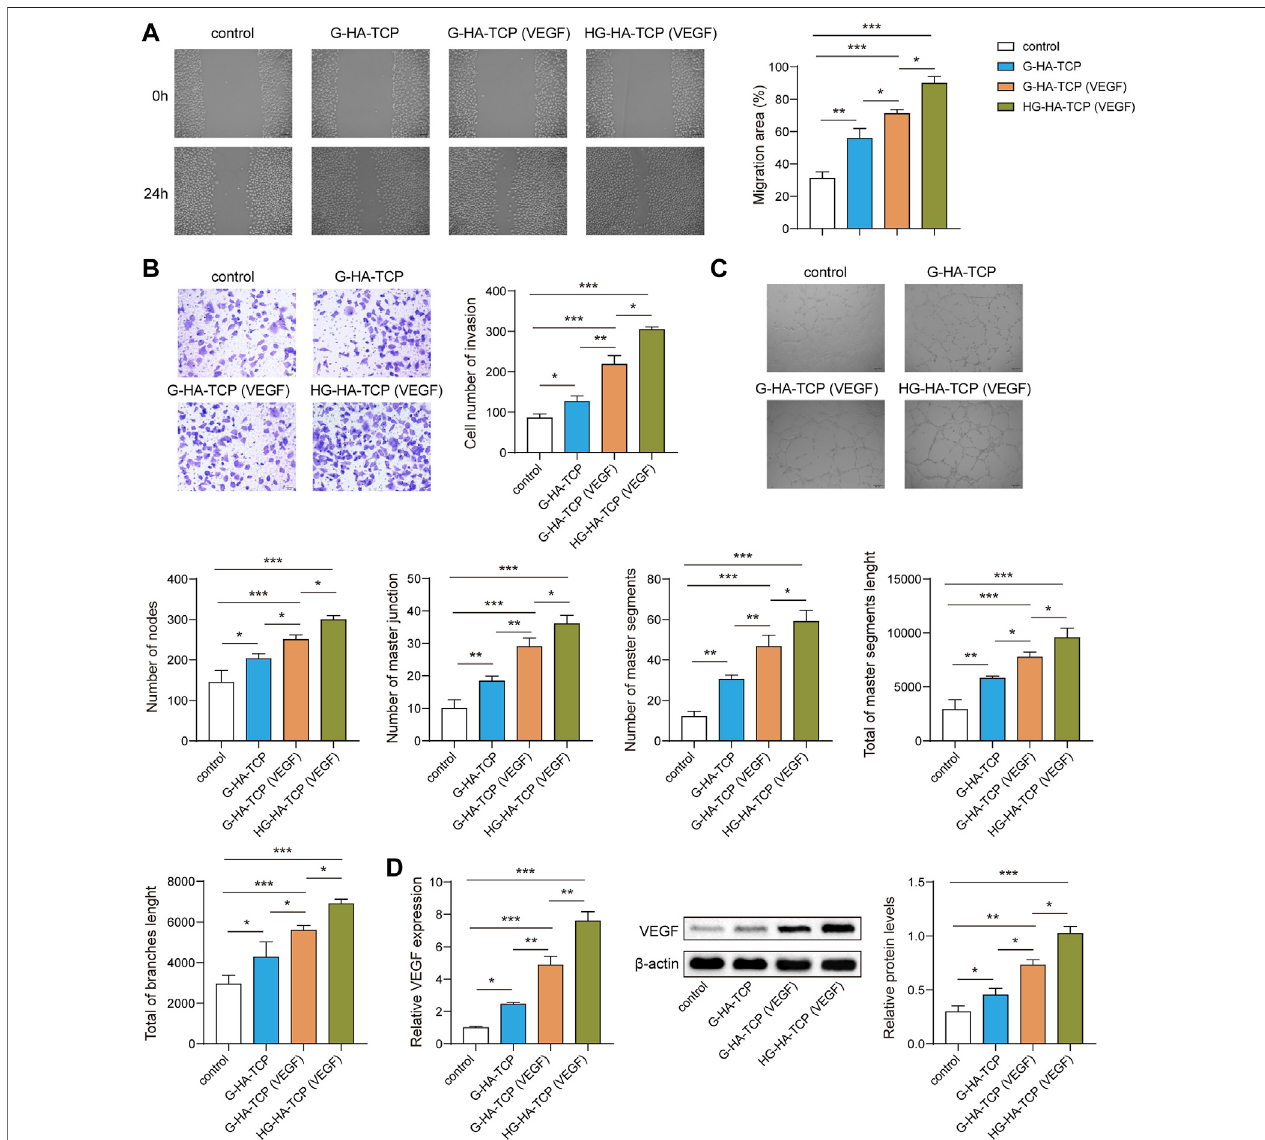
FIGURE6| HG-HA-TCP(VEGF)promotesendothelialcellangiogenesis. (A) Woundhealingassaywasperformedtodetectcellmigration. (B) Transwellassaywas performed for cell invasion measurement. (C) Tube formation assay was performed to assess angiogenesis in vitro . (D) VEGF expression was detected usingqRT-PCR and western blot n = 3. * p < 0.05, ** p < 0.01, *** p <